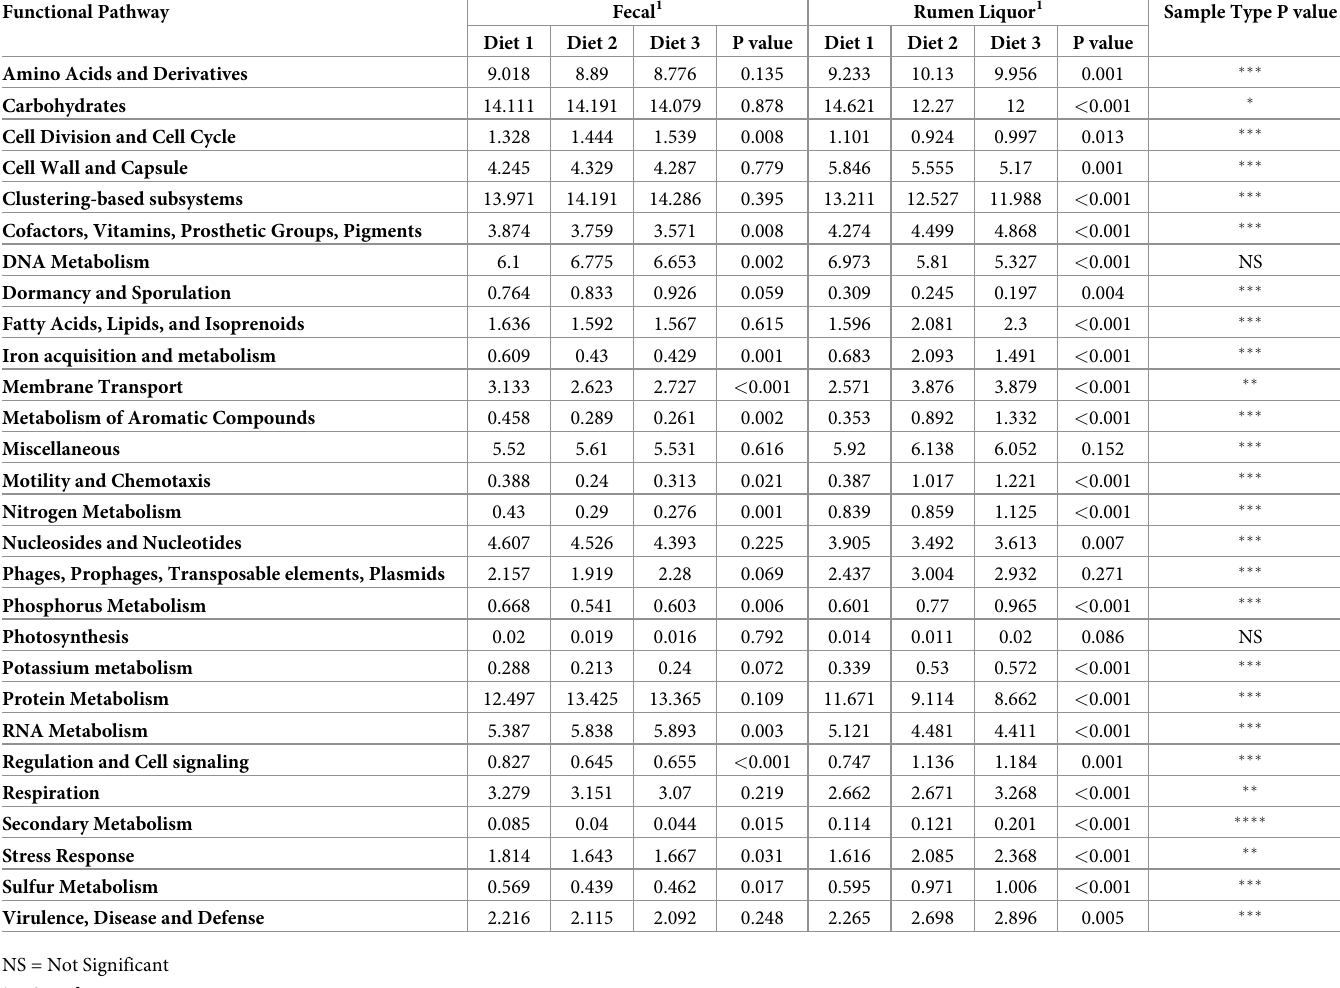
Table 1. Relative abundance (%) of level 1 subsystems classification of microbial functional